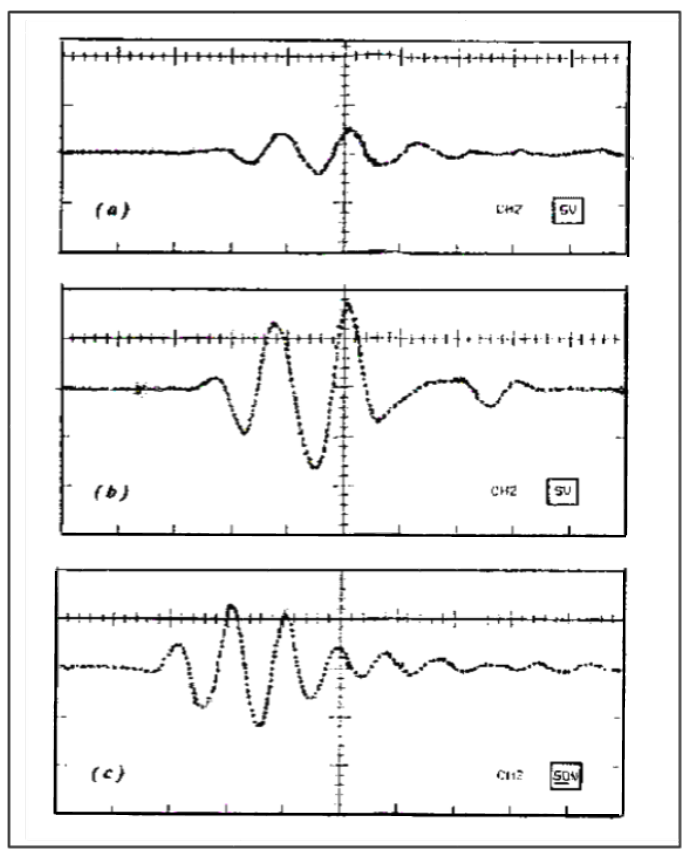
Figure 15. Our T–T received signals with both probes in direct contact: ( a , b ) KBA Delta Krautkrämer probes ( 5 V/div.). ( c ) L-N Tecal probes ( 50 V/div.). The driving was tuned in ( b , c ) responses. In all three cases: 1 μs/div. in horizontal axes.